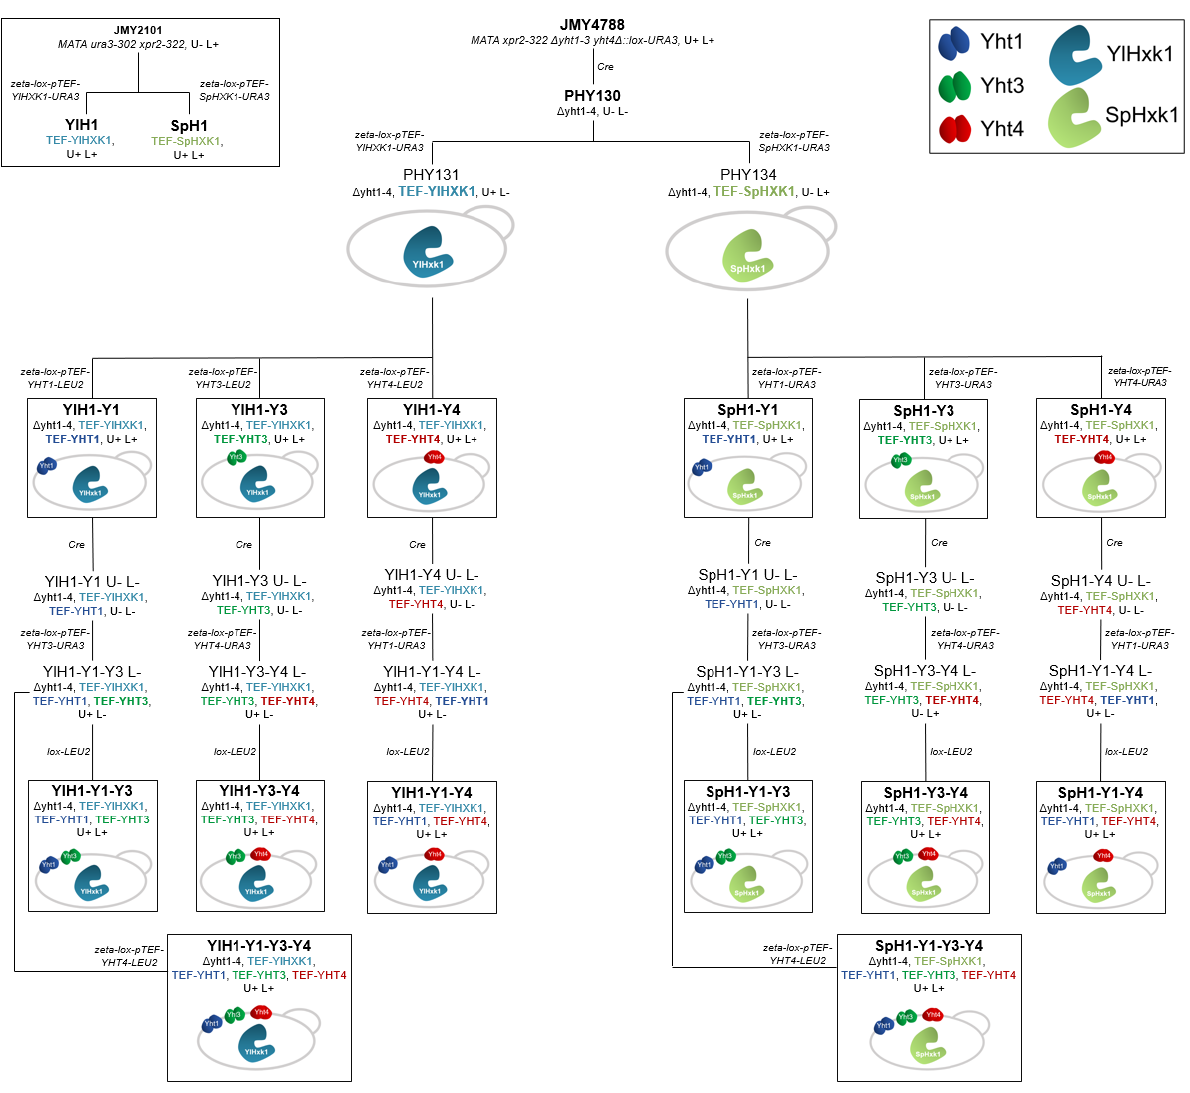
Figure 6. Construction of Y. lipolytica strains expressing hexokinases and hexose transporters. A detailed list of the Y. lipolytica strains used in this study is available in Table S4.